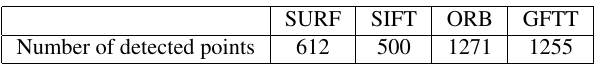
Table 2: Number of detected points, based on the orthoimage of Figure 6b